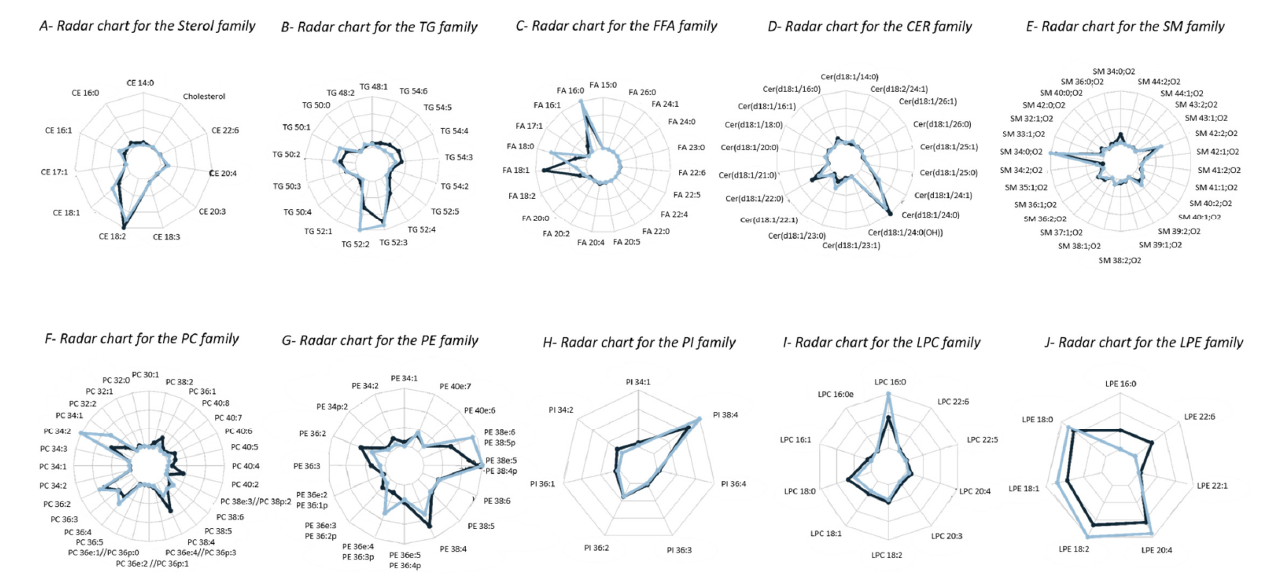
Figure 2. Radar chart of % of molecular species per lipid class generated for SRM195 published data (medium blue line) compared to % molecular species per class of lipid generated for data obtained with the new SFC method (dark blue line). ( A ) Sterol, ( B ) Triacylglyceride (TG), ( C ) Free fatty acid (FFA), ( D ) Ceramides (Cer), ( E ) Sphingomyelin (SM), ( F ) Phos- phatidylcholine (PC), ( G ) Phosphatidylethanolamine (PE), ( H ) Phosphatidylinositol (PI), ( I ) Lyso-phosphatidylcholine (LPC); ( J ) Lyso-phosphatidylethanolamine (LPE).